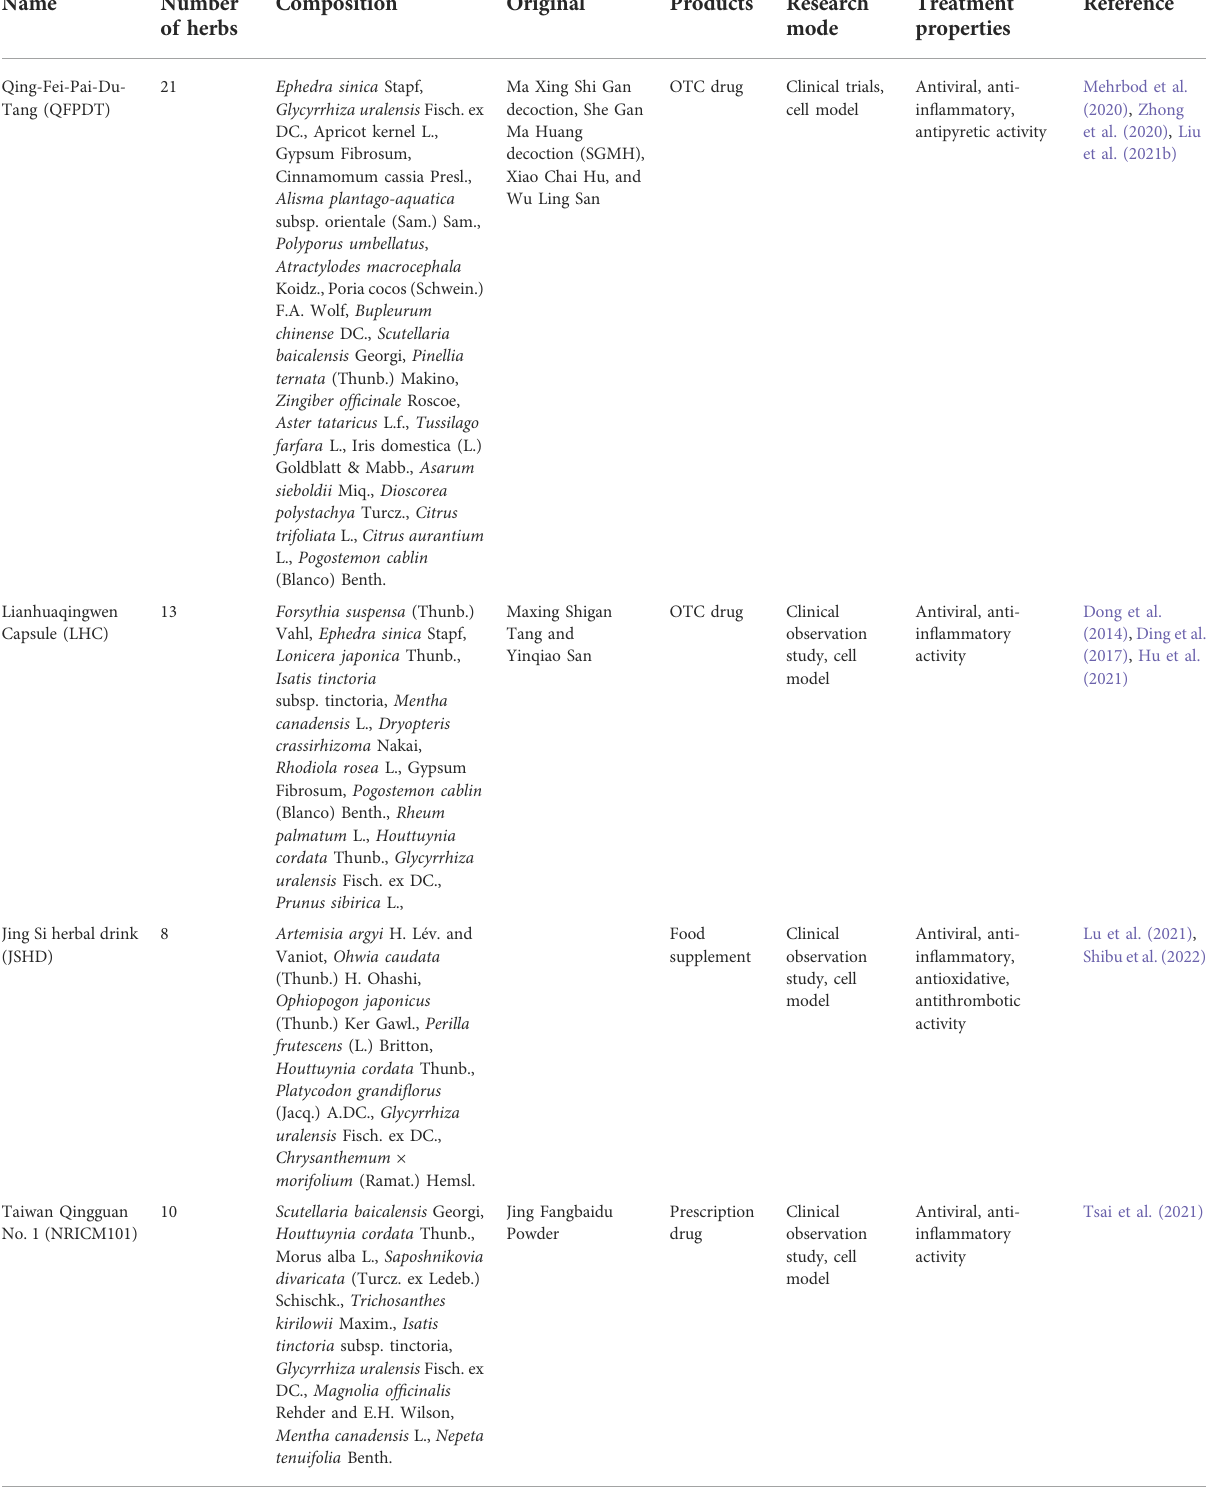
TABLE 1 Chinese herbal products for treatment of COVID-19.